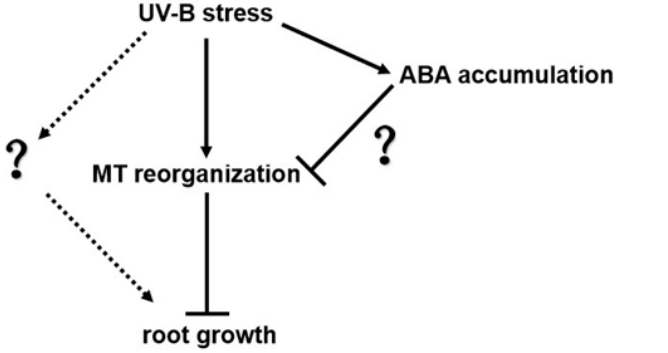
Figure 7. Proposed working model for abscisic acid (ABA) and cortical microtubule (MT)-mediated signaling pathways in A. thaliana as a response to UV-B stress. Enhangce . Repress .